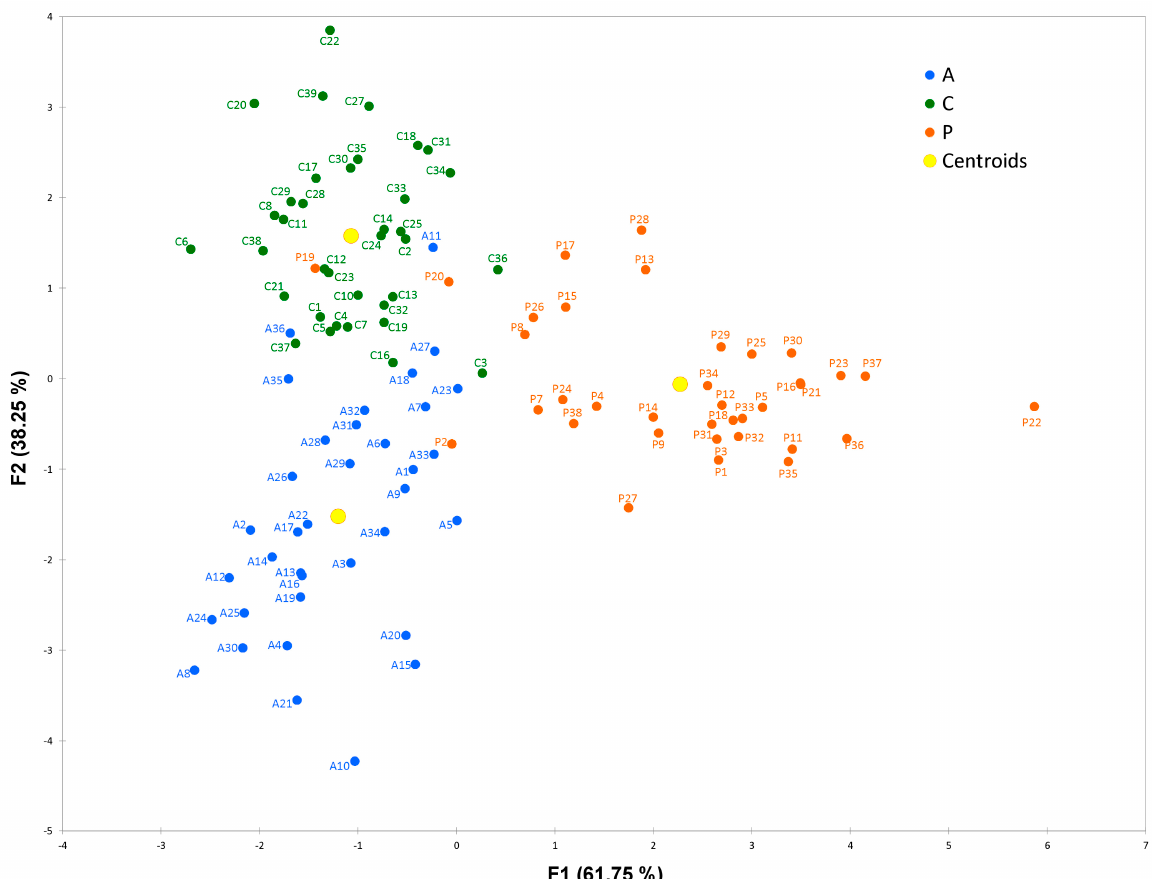
Figure 4. LDA classification of HCs, AIHp and PBCp subjects. Centroids represent the average subject position of each group.